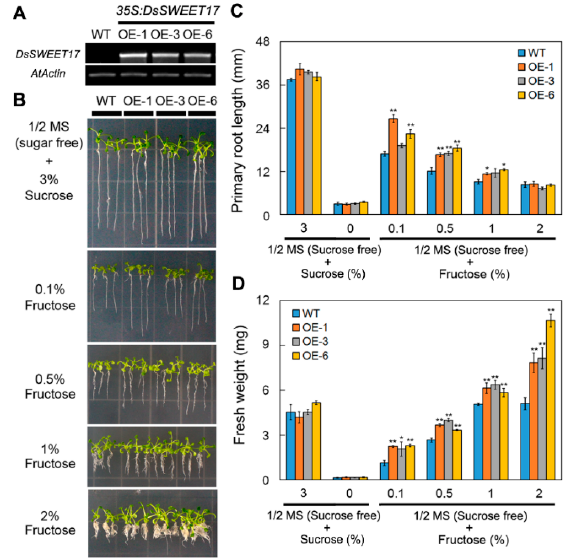
Figure 4. Growth of wild type (WT) and DsSWEET17 transgenic Arabidopsis seedlings on different sugar (sucrose and fructose) sources. ( A ) Semi-quantitative PCR analysis of DsSWEET17 expression in WT and transgenic Arabidopsis lines (OE-1, OE-3, and OE-6); ( B – D ) Seedling growth ( B ); root length ( C ); and fresh weight ( D ) of WT and three transgenic lines on 1/2 MS medium (sucrose free) containing different concentrations of sucrose or fructose. Asterisks indicate significant differences between WT and transgenic lines (* p < 0.05; ** p < 0.01; Student’s t test). Error bars show the SD of the values from three replicates.